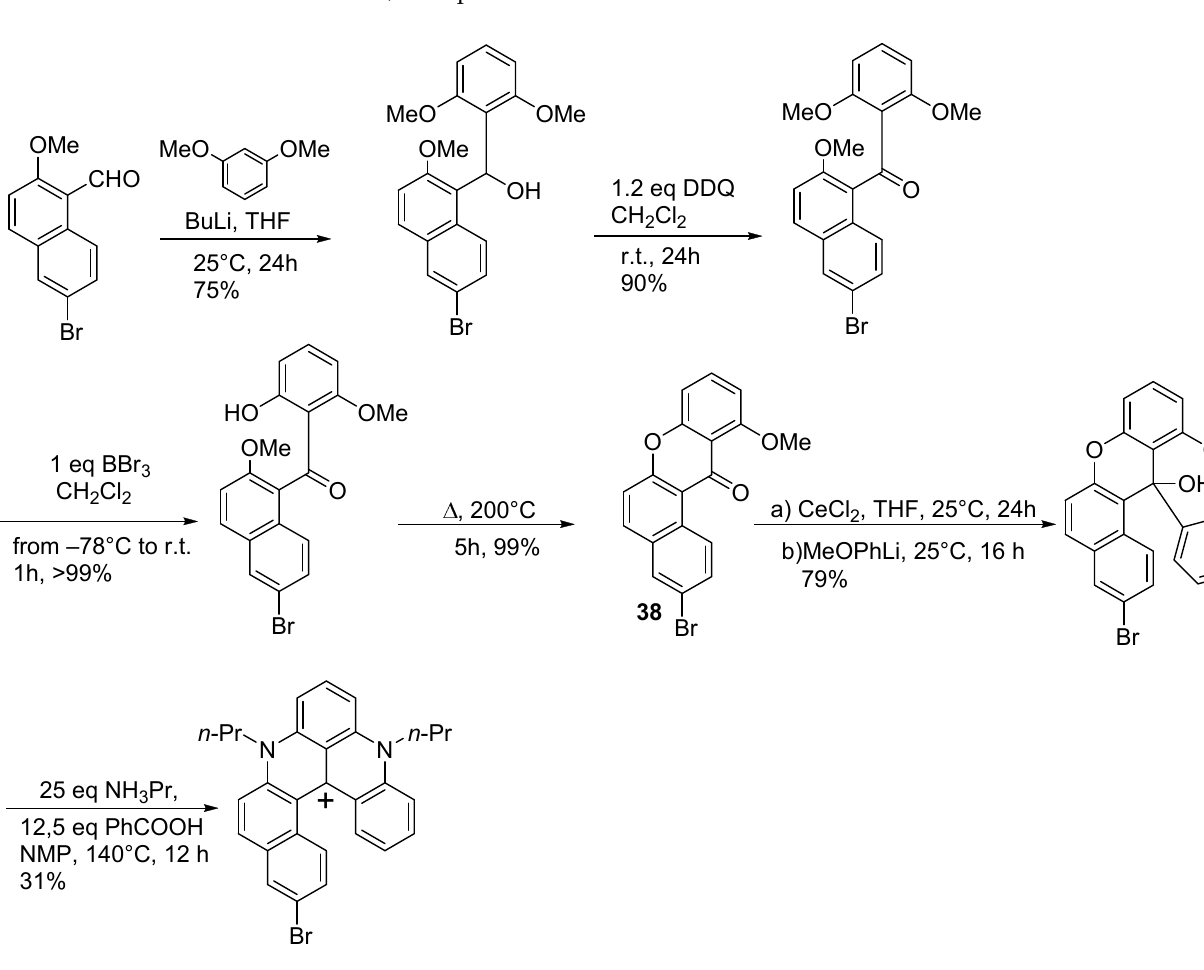
Scheme 30. Introduction of aryl and alkynyl groups by the substitution of bromine